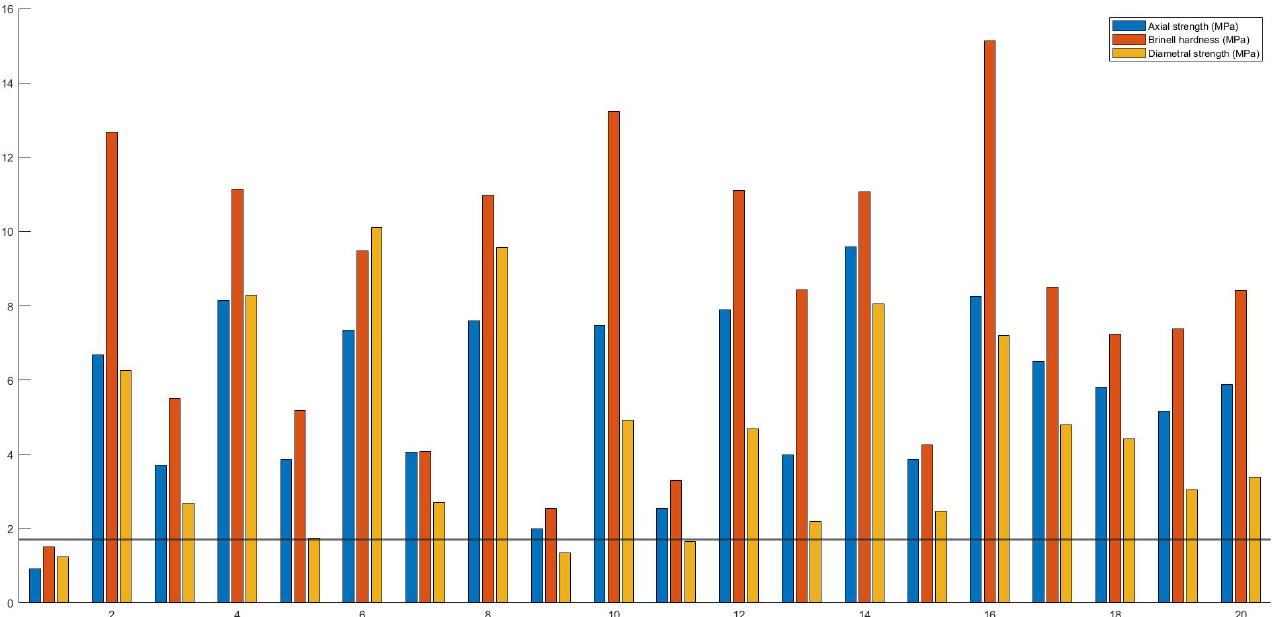
Figure 6. A comparison of the tensile strengths of FDM 3D-printed caplets as determined by diametral and vertical compression, and the Brinell hardness. The horizontal line at 1.7 MPa represents the minimal tensile strength.